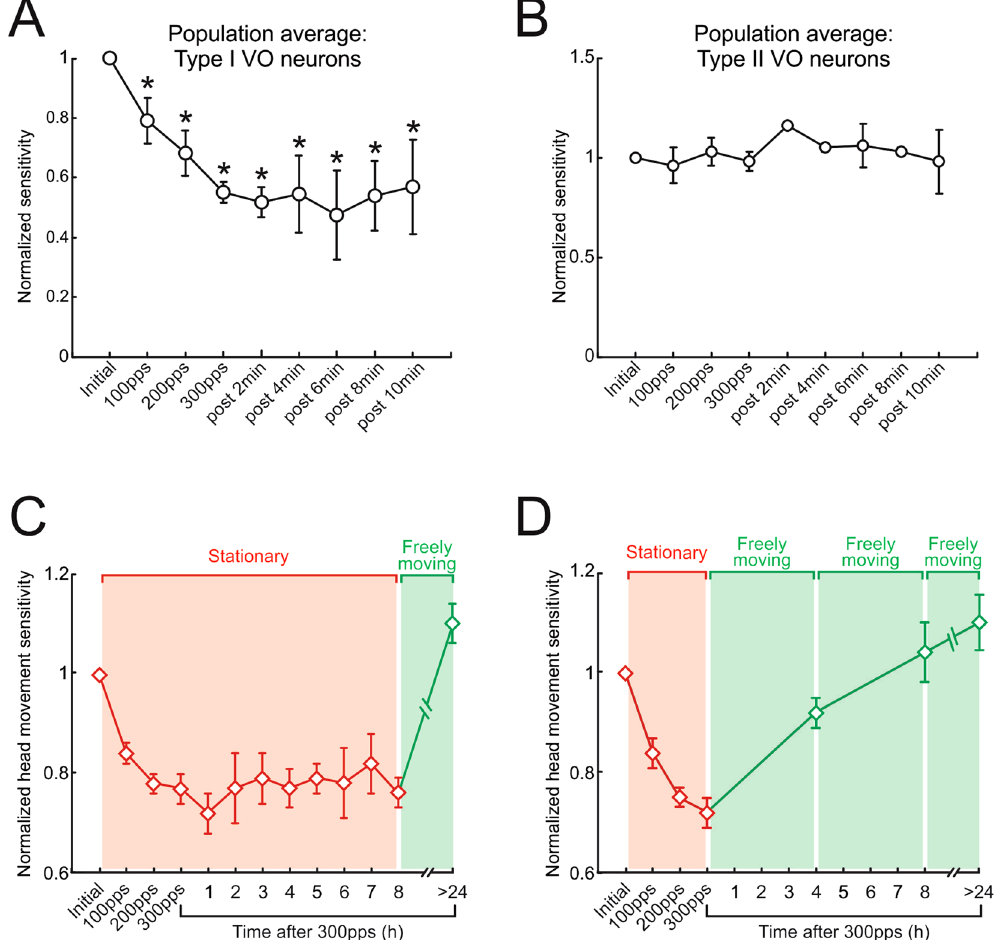
Figure 6. Recovery of neuronal and behavioral responses following activation of the vestibular nerve. ( A,B ) Normalized sensitivity over a period of 10 minutes for population of type I ( A ) and type II ( B ) VO neurons following activation of the vestibular nerve. ( C ) Normalized head movement sensitivity for an 8-h period following activation of the vestibular nerve when animal remained stationary. ( D ) Normalized head movement sensitivity for an 8-h period following activation of the vestibular nerve when animal returned to its home cage in between testing sessions. Error bars represent ±